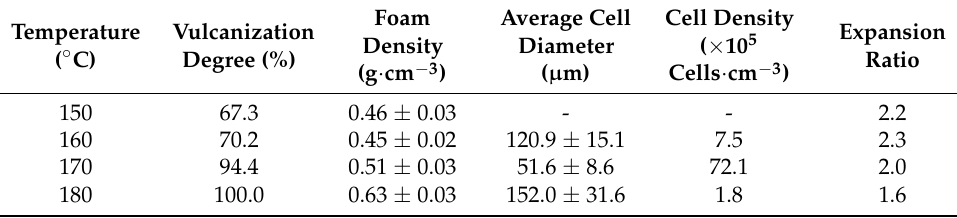
Figure 9. Cell morphology of foamed samples at different foaming temperatures: ( a ) 150 °C; ( b ) 160 °C; ( c ) 170 °C; ( d ) 180 °C. Table 5. Parameters of foamed samples at different foaming temperatures.